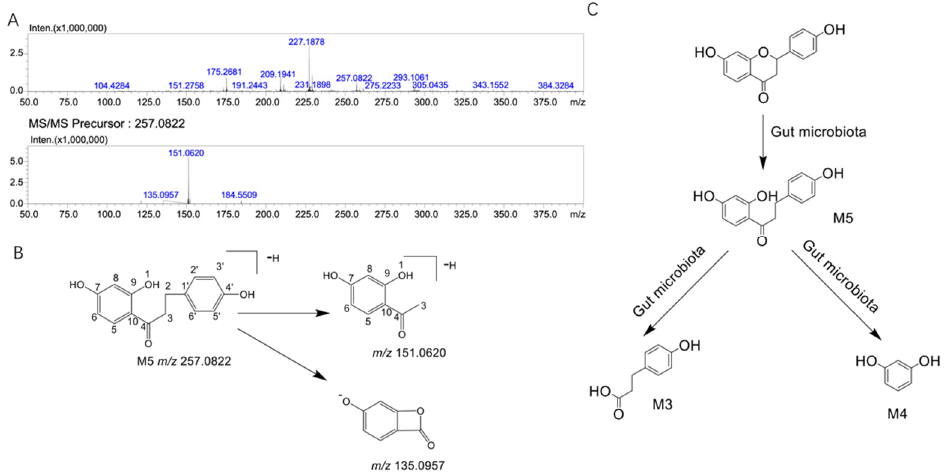
Figure 4. MS n data of the liquiritigenin metabolite M5 and the metabolic pathway of liquiritigenin in the gut microbiota. ( A ): MS n data of liquiritigenin metabolite M5; ( B ): possible cleavage of liquiritigenin metabolite M5; ( C ): metabolic pathway of liquiritigenin in the gut microbiota system (liquiritigenin is metabolized in the gut microbiota to produce M3, M4, and